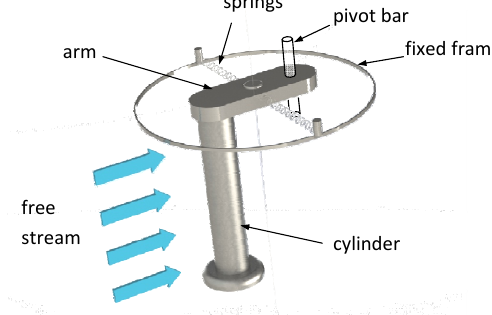
Figure 1. Schematic of the hydrokinetic energy converter under study.